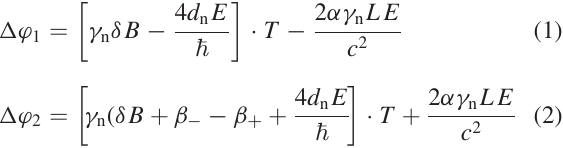
Figure 2. Installation of the Beam EDM prototype experiment at the PF1b beam line at the Institut Laue-Langevin. The total length of the setup is approximately seven meters. The neutron beam exits the wall at the experimental site in the lower left corner of the image. The neutron detector is located at the upper right corner of the image. The green coils are neutron resonance spin flip coils separated by 4m. An approximately 3.4m long aluminum vacuum pipe is installed between the